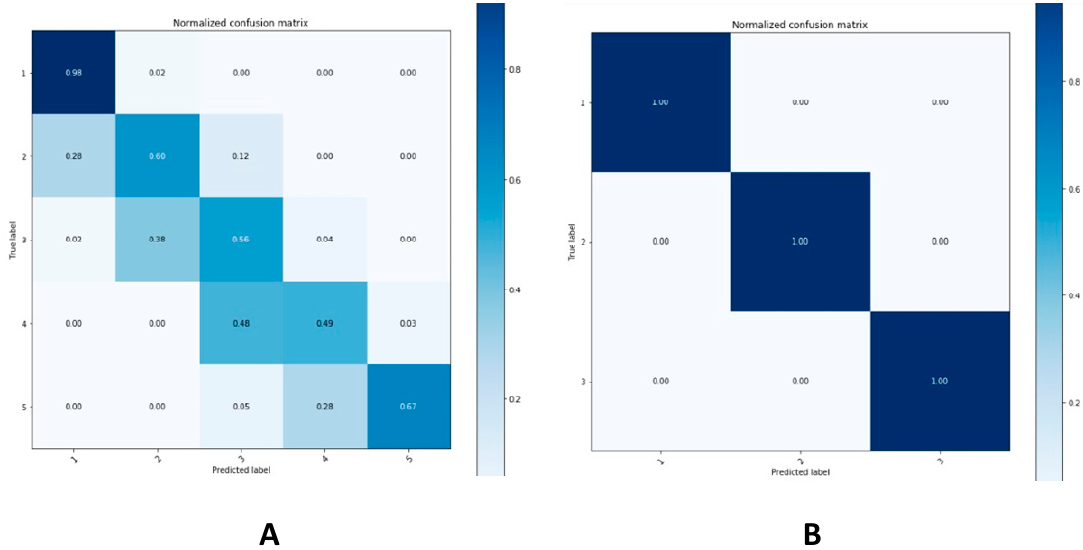
Figure 7. ( A ) The confusion matrix of row seat estimation. ( B ) The confusion matrix of column seat estimation.